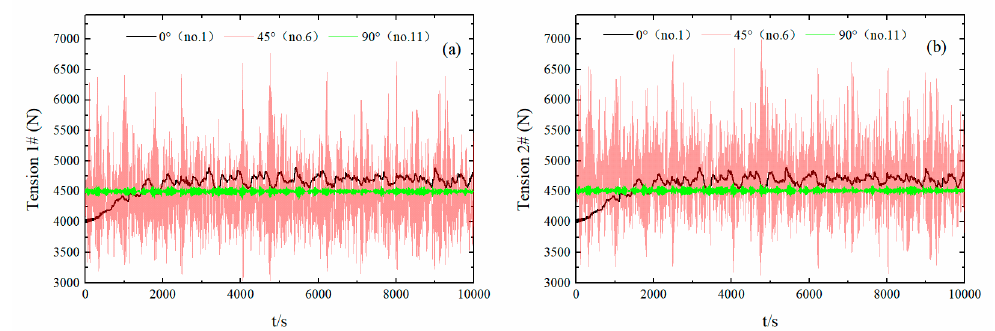
Figure 20. Floating anchor chain tension time-history curves with different wave direction angles. (Sub-figures: ( a ) time-history curves of anchor chain I tension; ( b ) time-history curves of anchor chain II tension.).